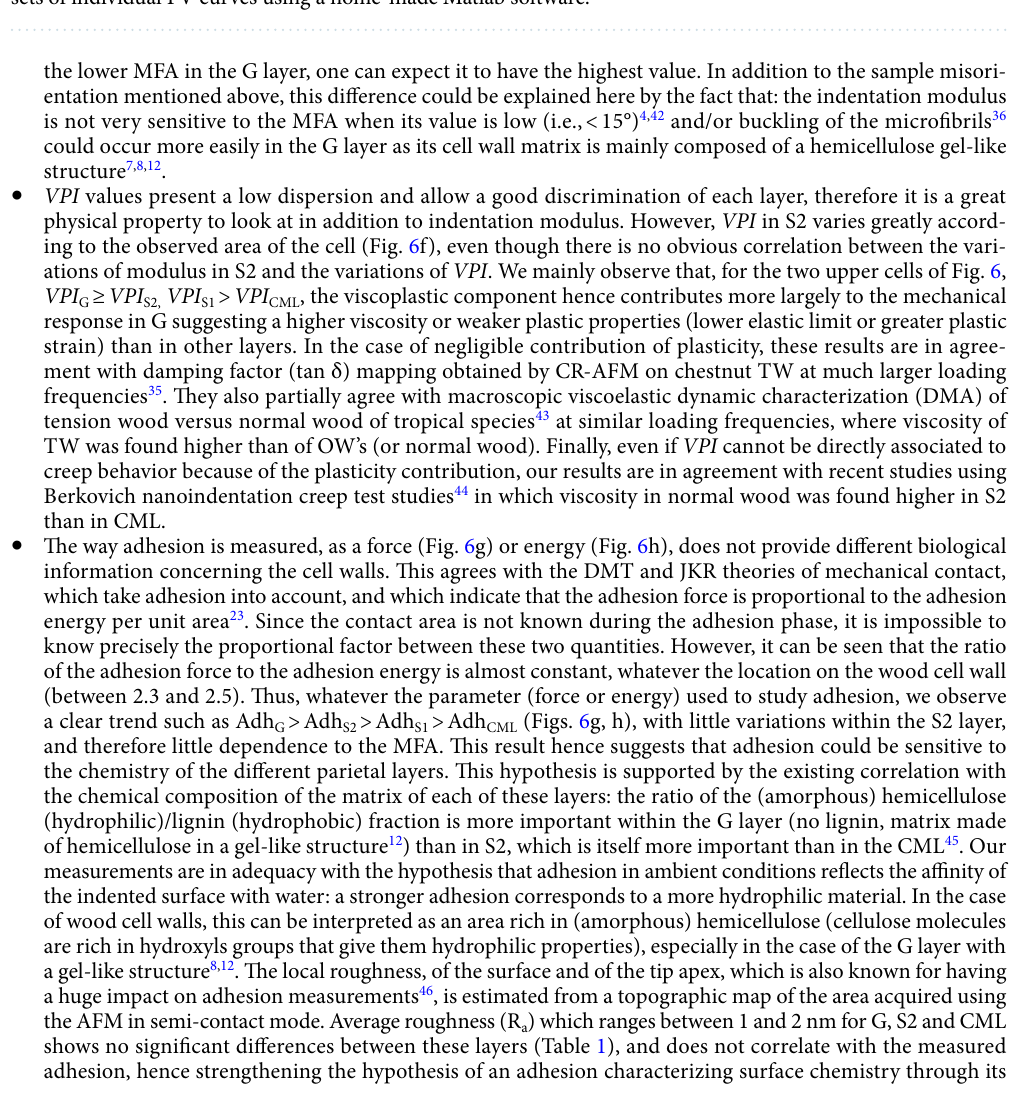
Figure 6. Maps obtained for two sets of parameters: ( a – d ) average indentation depth ( h c ) is 2 nm, indentation time is 0.02 s, ( e – h ) average indentation depth ( h c ) is 10 nm, indentation time is 0.7 s. ( a , e ) Indentation modulus, ( b , f ) viscoplasticity index, ( c , g ) adhesion force, ( d , h ) adhesion energy. Mappings are generated from sets of individual FV curves using a home-made Matlab